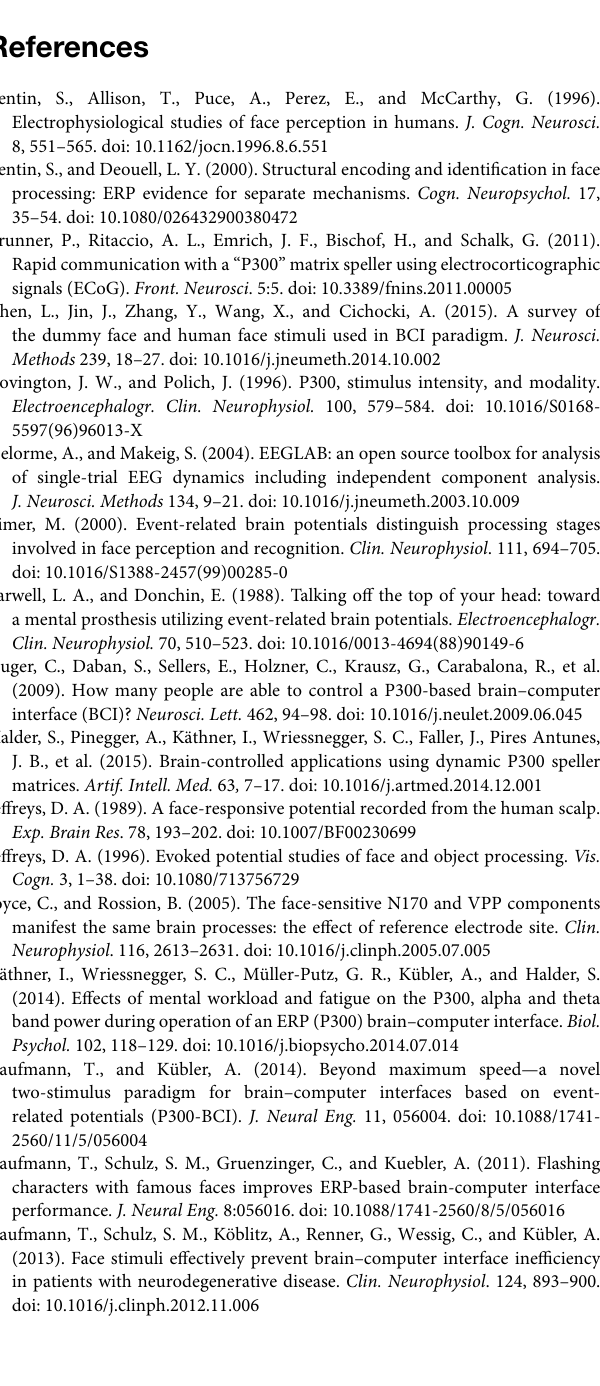
Supplementary Table 1 | Performance for each participant and for all conditions listed by the number of flash sequences. Online spelling with one flash sequence was only tested for the glasses A